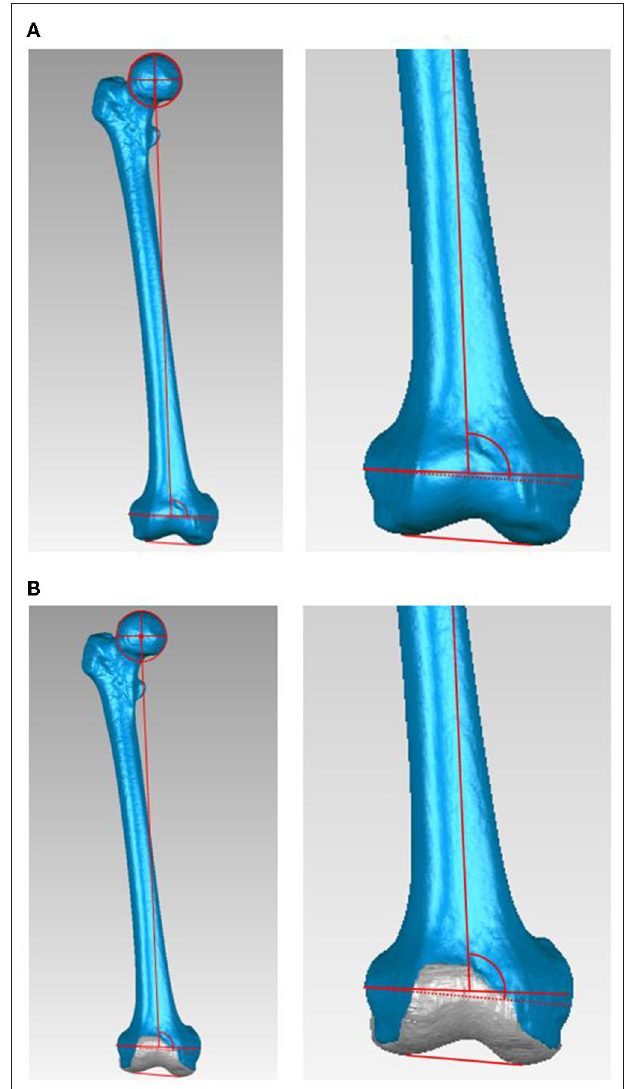
FIGURE 3 | The mechanical lateral distal femoral angle (mLDFA). The mLDFA was defined as the angle between the femoral mechanical axis and the line connecting the most distal point of the osseous and the cartilaginous contours, respectively, of the lateral and medial distal condyles on the coronal plane perpendicular to the Z-axis. (A) The mLDFA on the osseous contours. (B) The mLDFA on the cartilaginous